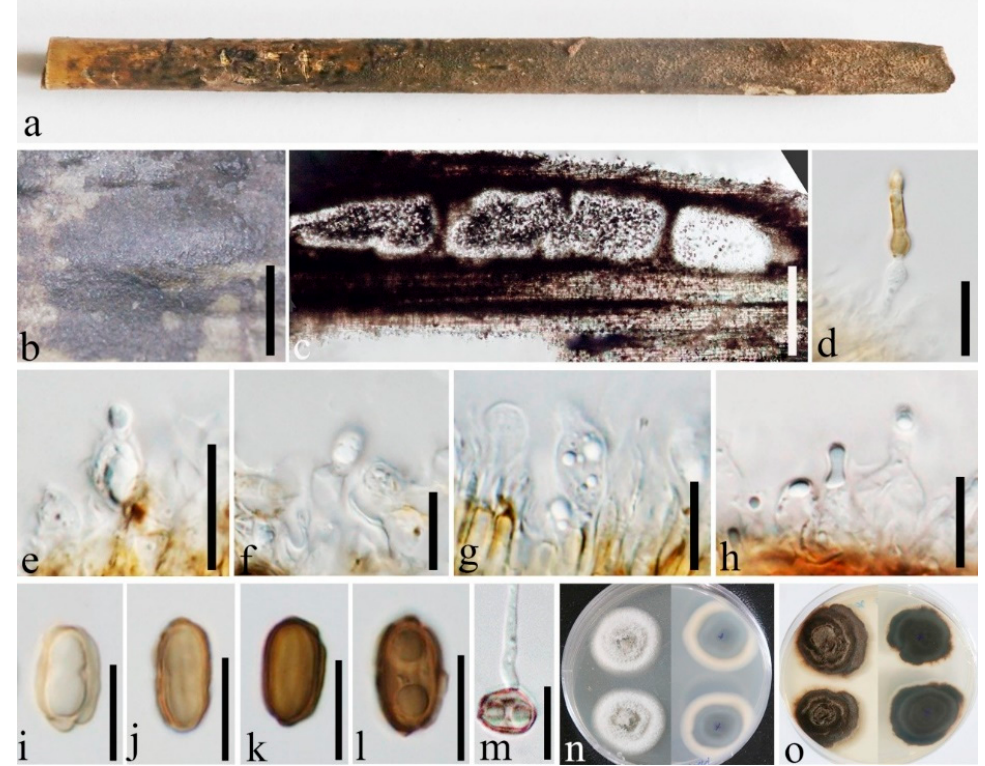
Figure 11. Roussoella tuberculata (GMB1317, new country record). ( a ) Bamboo specimen; ( b ) black conidioma on host surface; ( c ) vertical sections of conidiomata; ( d – h ) conidiogenous cells and developing conidia; ( i – l ) conidia; m: germinating conidium; ( m ) germinating conidium; ( n ) cultures on PDA from above and below after two weeks; ( o ) cultures on PDA from above and below after four weeks. Scale bars: ( b ) = 500 μ m, ( c ) = 200 μ m, ( d – f , m ) = 15 μ m, ( h – l ) = 10 μ m.